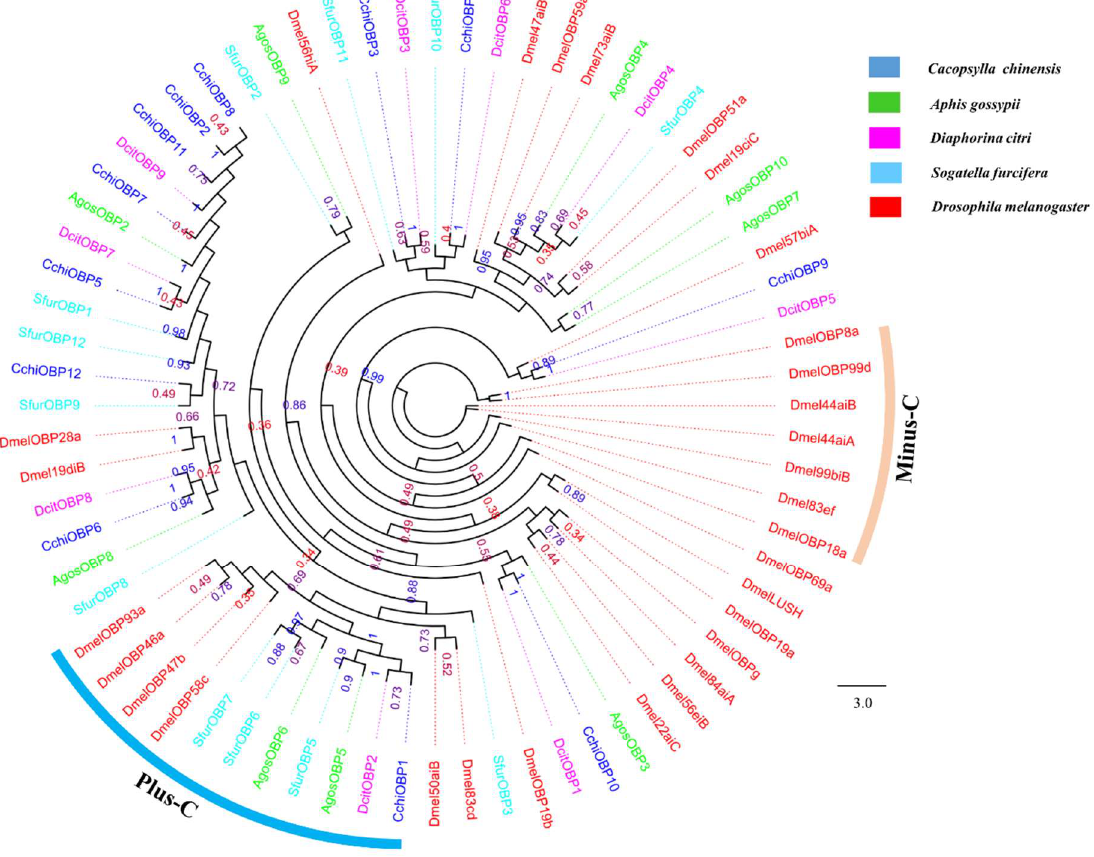
Figure 3. Phylogenetic tree of insect odorant binding proteins (OBPs). The C. chinensis translated genes are shown in blue. Abbreviations of other insects are as follows: Aphis gossypii , Diaphorina citri, Sogatella furcifera, Drosophila melanogaster . This tree was constructed using PhyML based on the alignment results of ClustalX2.0.